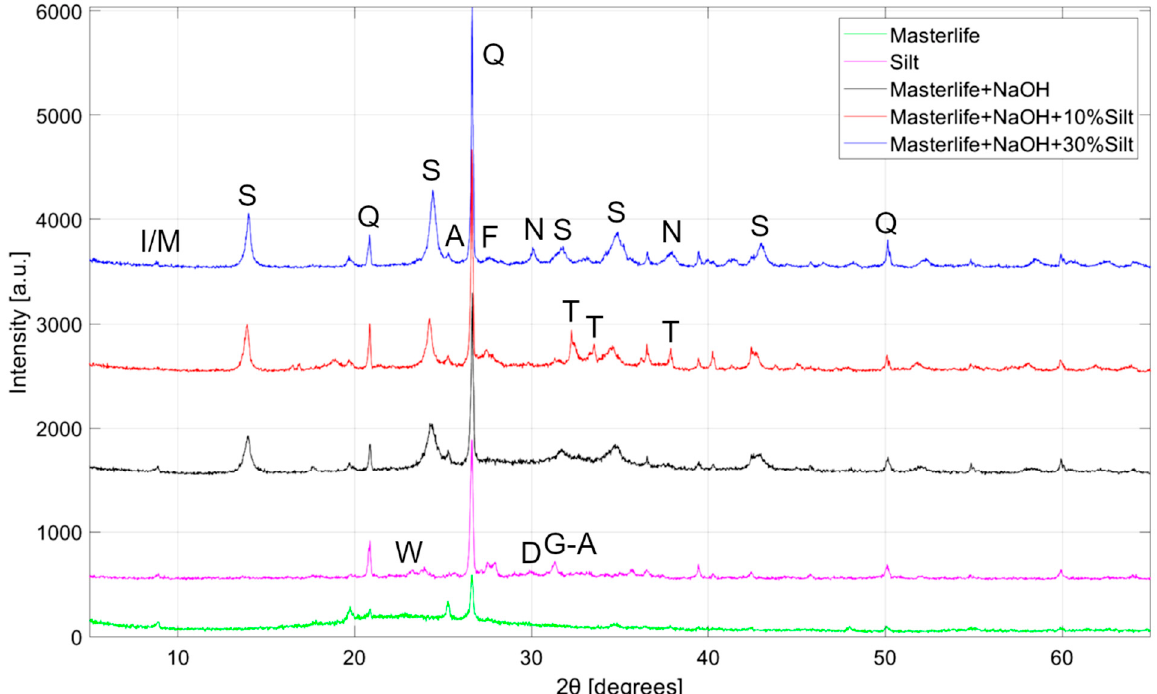
Figure 3. XRD patterns of metakaolin Masterlife MK828 (green pattern), waste silt (magenta pattern) and of samples 1, 2 and 3, made with Masterlife MK828, 12M NaOH solution and 0% (black pattern), 10% (red pattern) and 30% (blue pattern) of waste silt, respectively. The principal peaks associated with each mineralogical phase are indicated by a letter: Q = Quartz; A = Anatase; F = Feldspar; I/M = Illite/Mica; S = hydrated Sodalite; T = Thermonatrite; N = Natrite; G ‐ A = Gehlen ‐ ite—Åkermanite solid solution; D = Diopside; W = Wollastonite.